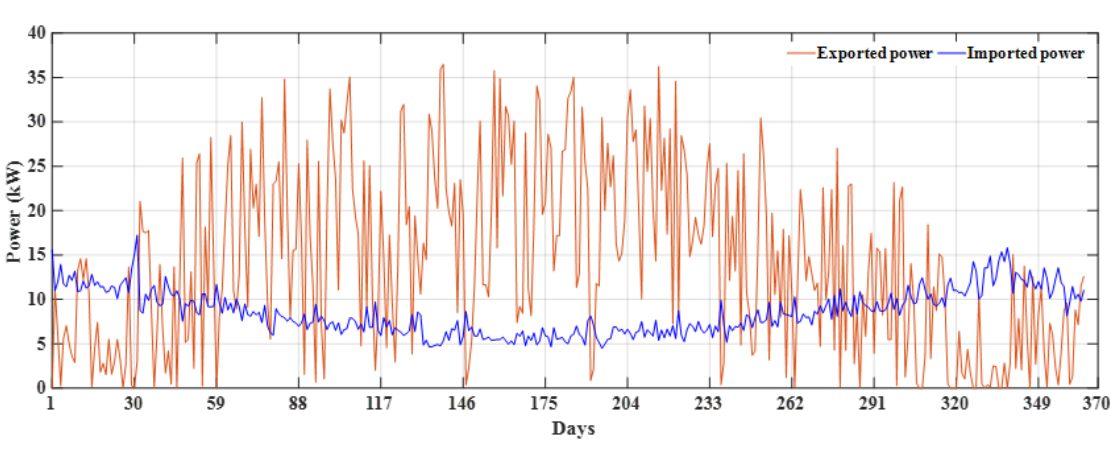
Figure 7. Import and export of the power profile with solar PV and no battery.